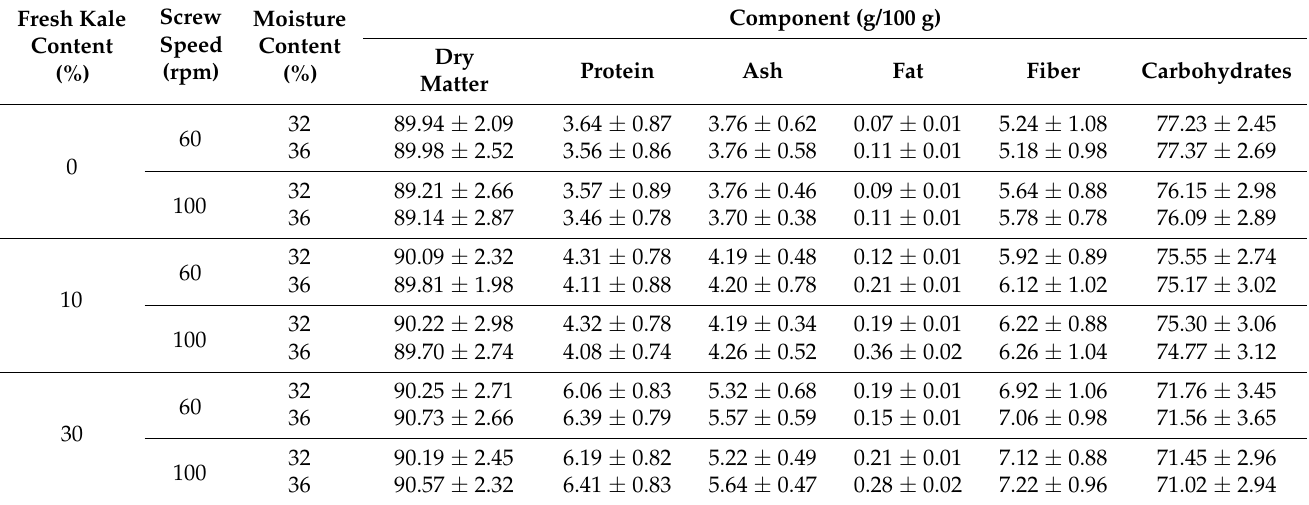
Table 7. Basic composition of snack pellets with the addition of fresh kale (n = 3, ±